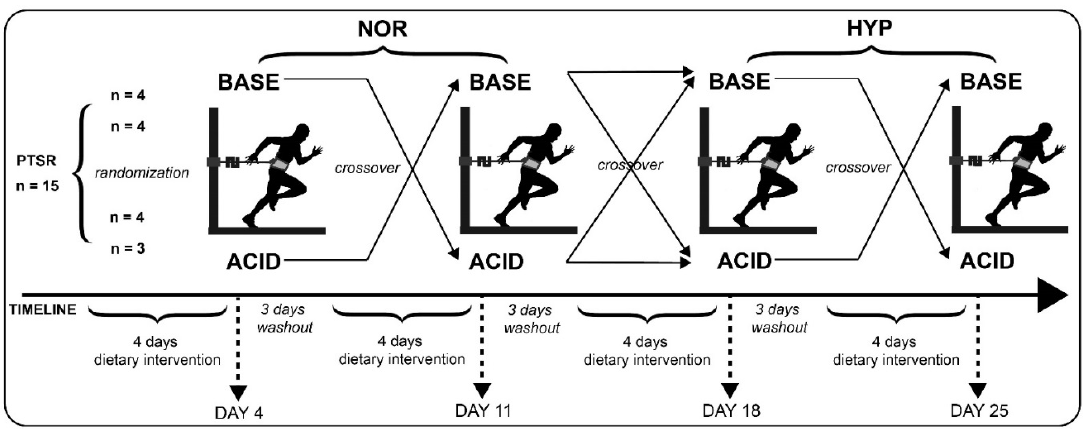
Figure 1. Experimental sequence. NOR = normoxia; HYP = hypoxia; PTSR = portable tethered sprint running test; ACID = acidizing diet; BASE = alkalizing diet.